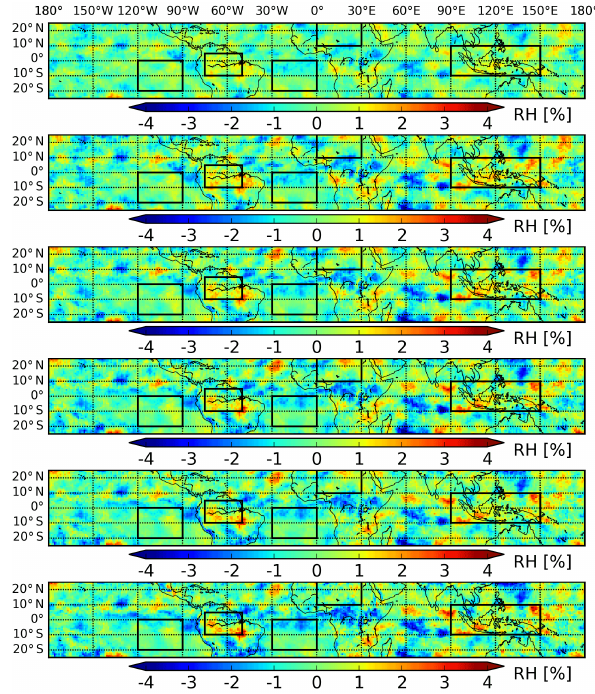
Figure 9. Mean difference of daily average of RH I calculated using only data from 09:30/21:30 local time and the daily average cal- culated using all hourly data. Depicts from top to bottom are for SAPHIR channels 1–6,